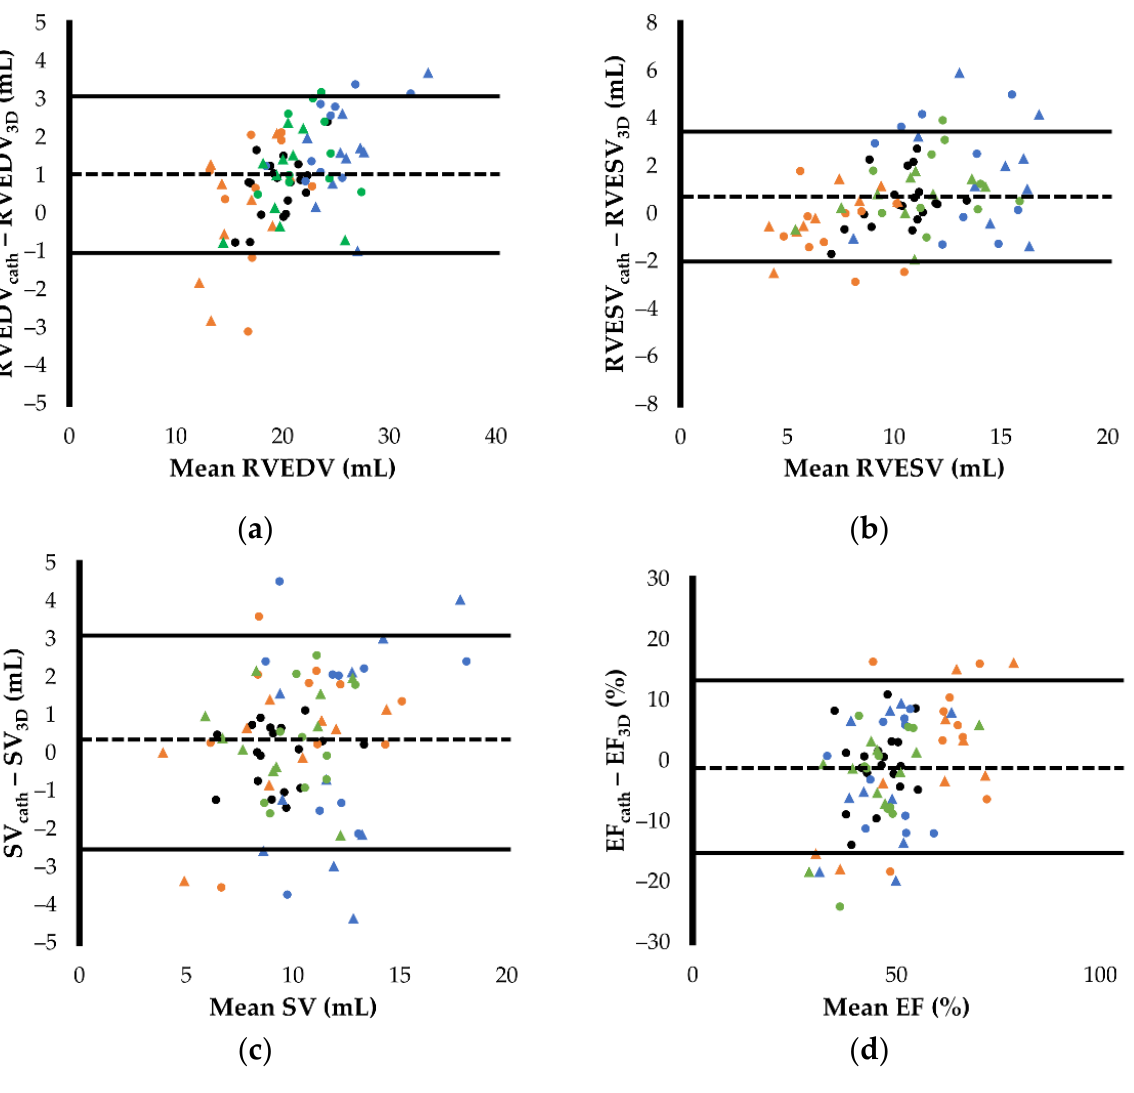
Figure 3. Agreements between the right ventricular morphology and function measured by right heart catheterization and real-time three-dimensional echocardiography demonstrated on Bland– Altman plots: ( a ) end-diastolic right ventricular volume (RVEDV); ( b ) end-systolic right ventricular volume (RVESV); ( c ) stroke volume (SV); ( d ) ejection fraction (EF). The horizontal solid and dotted lines represent the mean difference and the limits of agreement, respectively. Black round dots show the measurements of baseline. Orange round and triangular dots show the measurements of 5 and 10 µ g/kg/min dobutamine infusions, respectively. Blue round and triangular dots show the measurements of 15 and 30 min after acute volume load, respectively. Green round and triangular dots show the measurements of 15 and 30 min after furosemide administration,